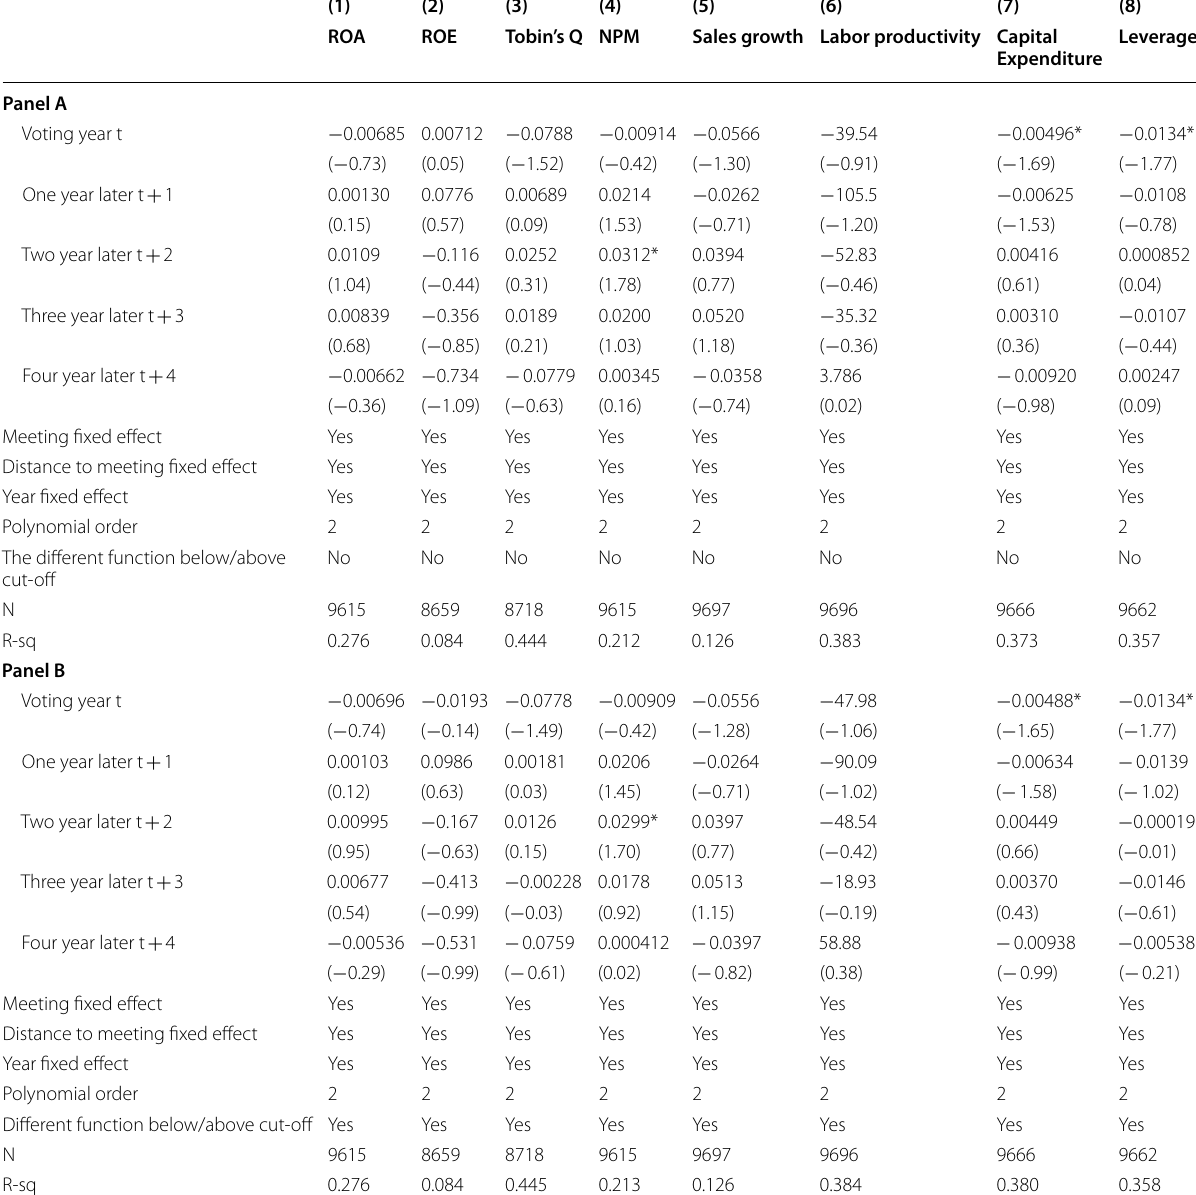
Table 10 Long-term effects of passing CSR